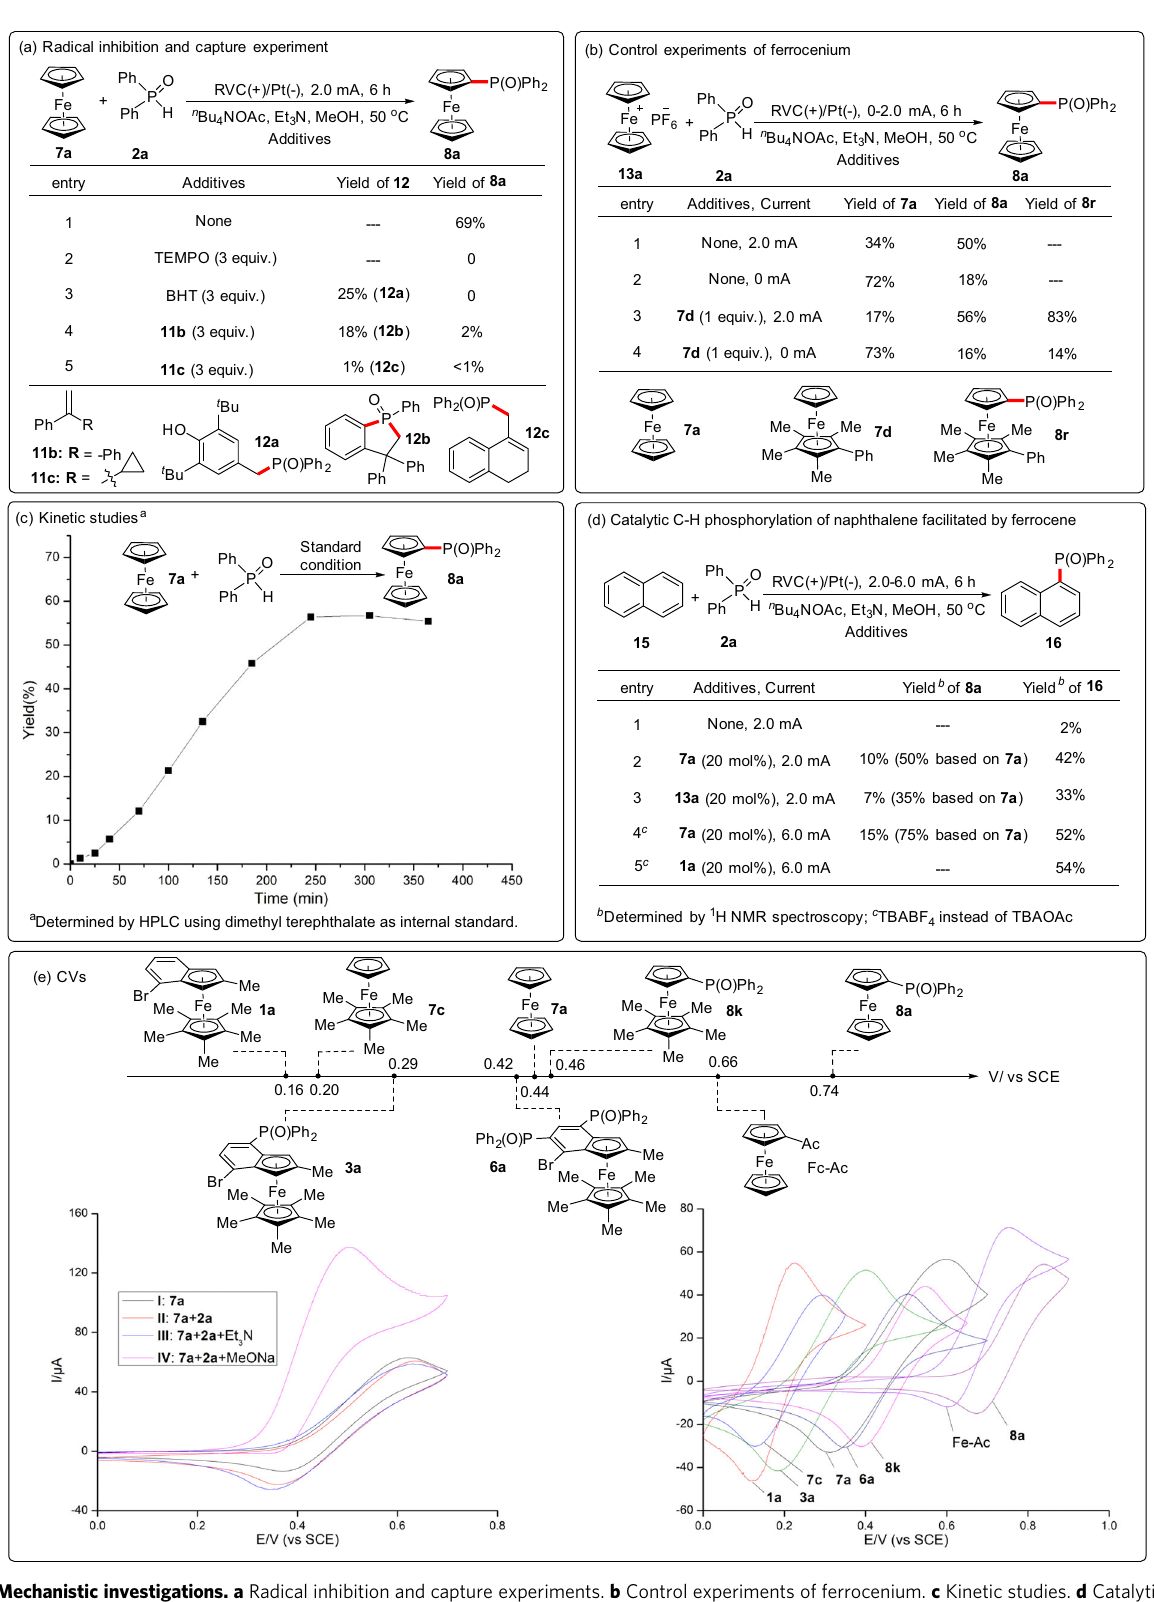
Fig. 4 Mechanistic investigations. a Radical inhibition and capture experiments. b Control experiments of ferrocenium. c Kinetic studies. d Catalytic C − H phosphorylation of naphthalene facilitated by ferrocene. e Cyclic voltammograms